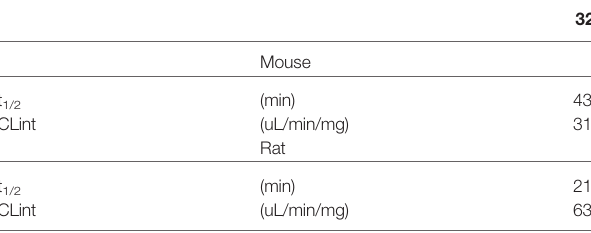
TABLE 1 | Plasma stability and